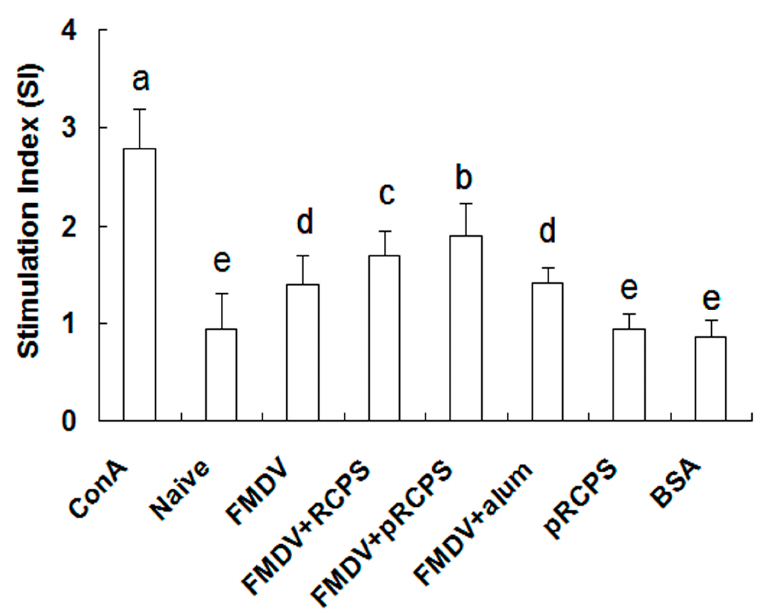
Figure 3. Effect of pRCPS on splenocytes proliferation in vitro. To investigate the effect of pRCPS on splenocyte proliferation in vitro, splenocyte were isolated from ICR mice in all groups on Day 14 after the second booster. splenocyte proliferation assay was performed by the CCK-8 method as described in Experimental Section. BSA as negative control, and ConA as positive control. The proliferation was expressed as stimulated index (SI). The different letters on a column differ significantly ( n = 10, p < 0.05).